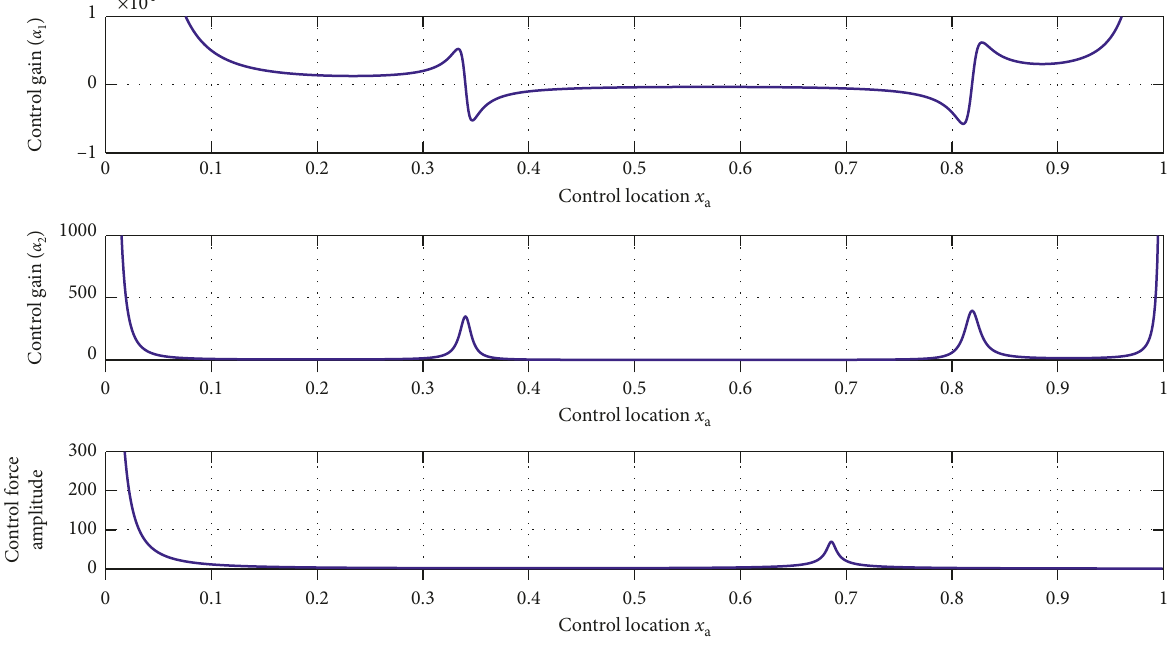
Figure 4: The design plot of the required control gains and amplitude versus control actuator location.